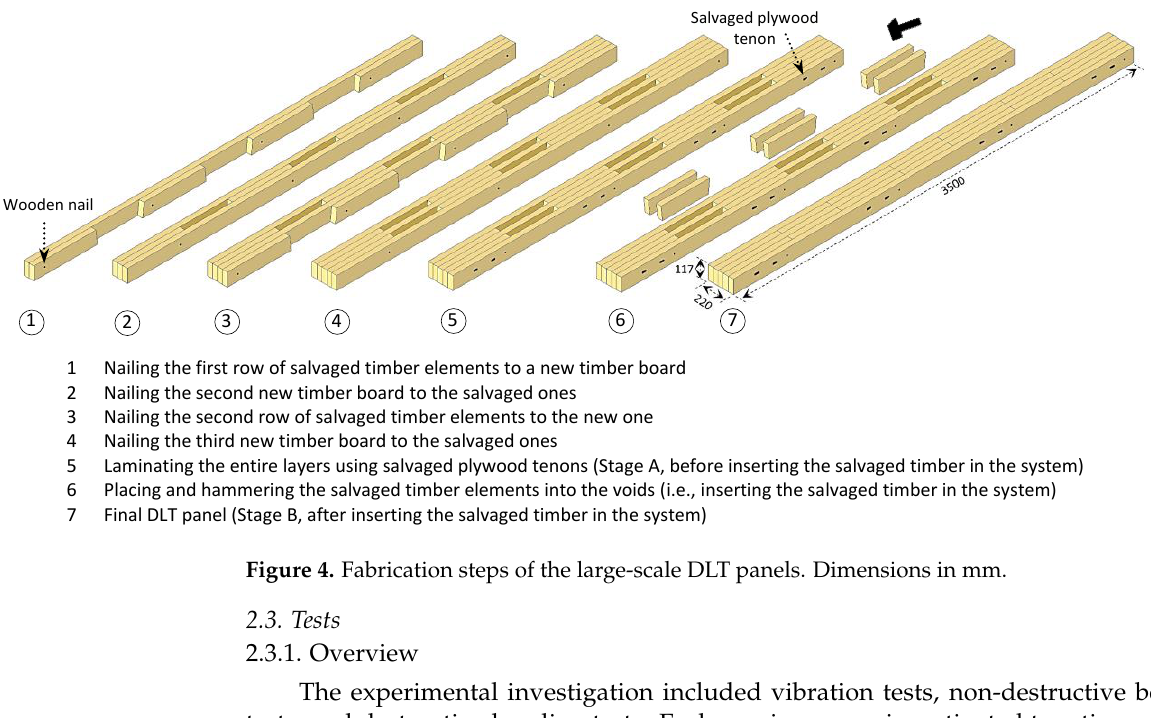
Figure 4. Fabrication steps of the large-scale DLT panels. Dimensions in mm.